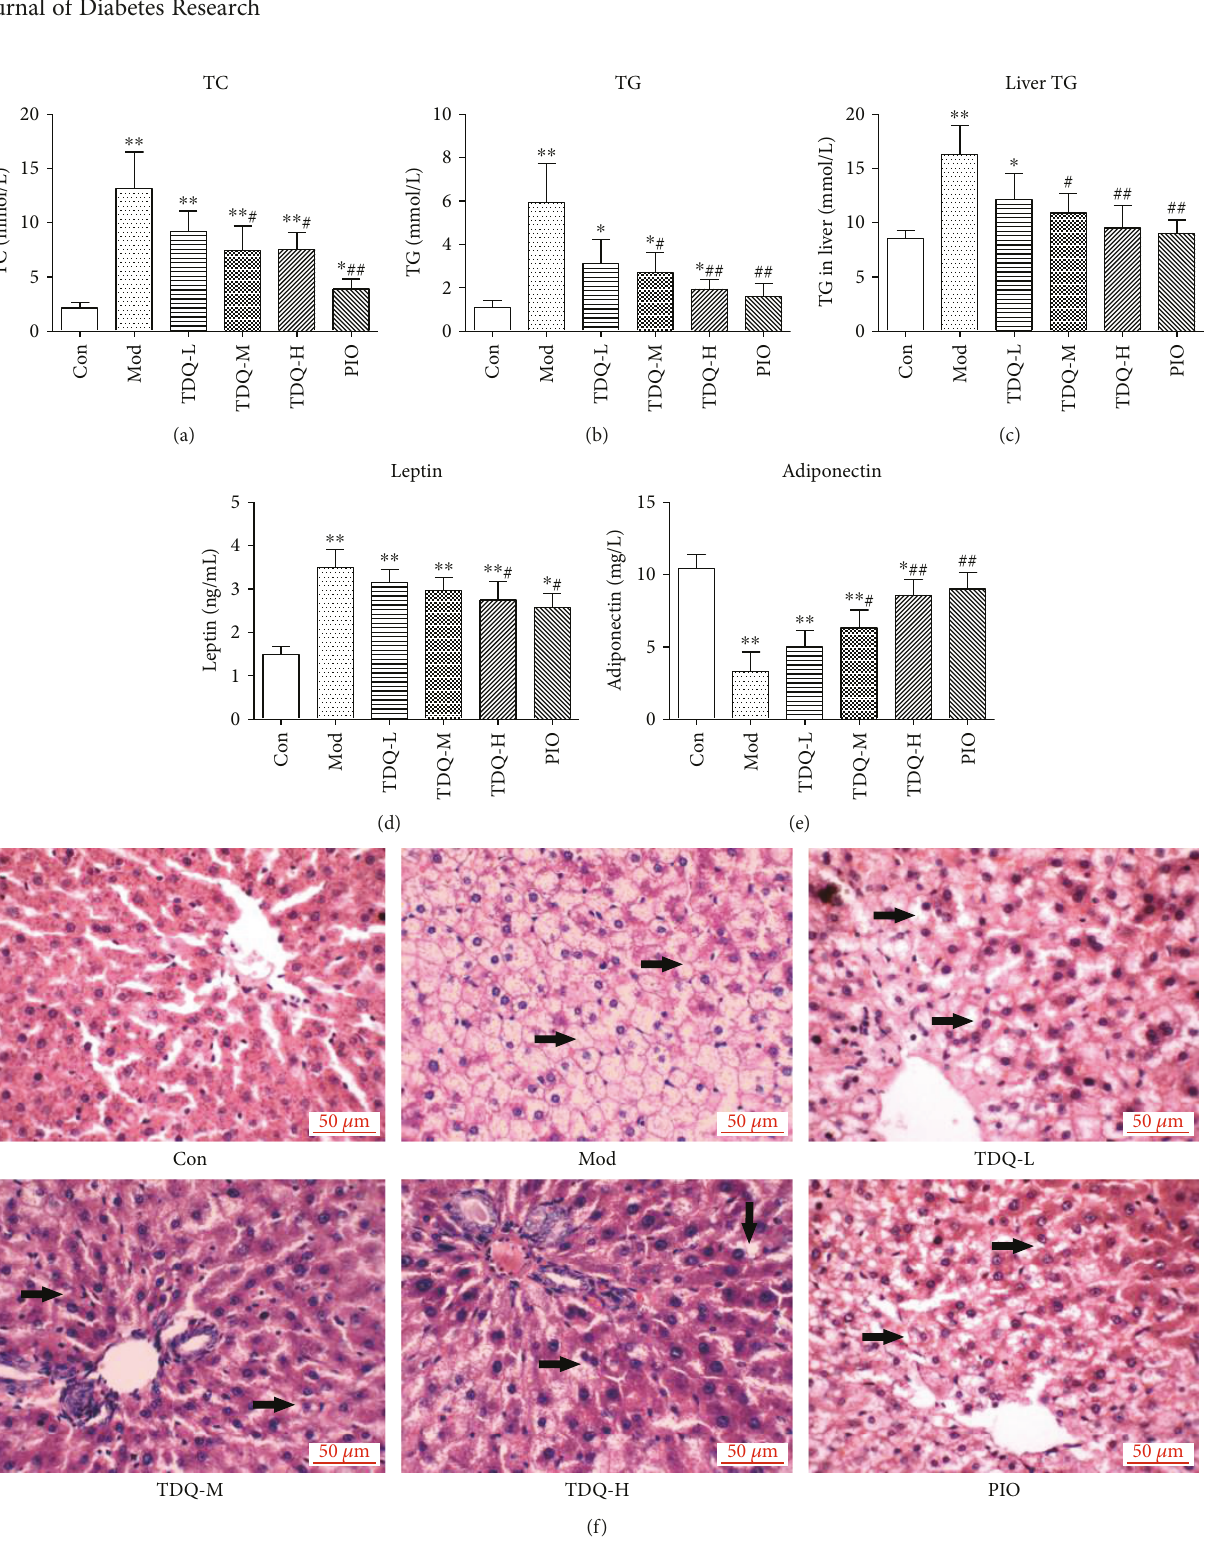
Figure 2: TDQ impaired lipid metabolism disorder in diabetic rats. (a – c) Biochemistry determination in serum and liver tissue of total cholesterol (TC) and triglycerides (TG). (d, e) Leptin and adiponectin levels in serum. (f) Histological analysis of hepatic tissues in each group. Steatosis and vacuolization (arrows). Conventional H&E staining was performed (magni fi cation: 400x). Data are presented as the mean ± SD . ∗ P < 0 05 and ∗∗ P < 0 01 vs. Con; # P < 0 05 and ## P < 0 01 vs.